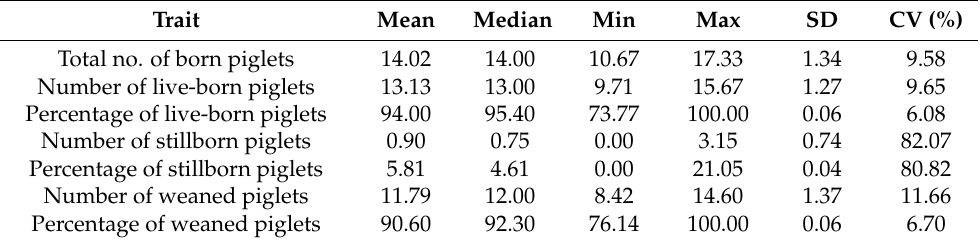
Table 9. Summary statistics of the traits related to litter size in the Polish Landrace sows. Trait